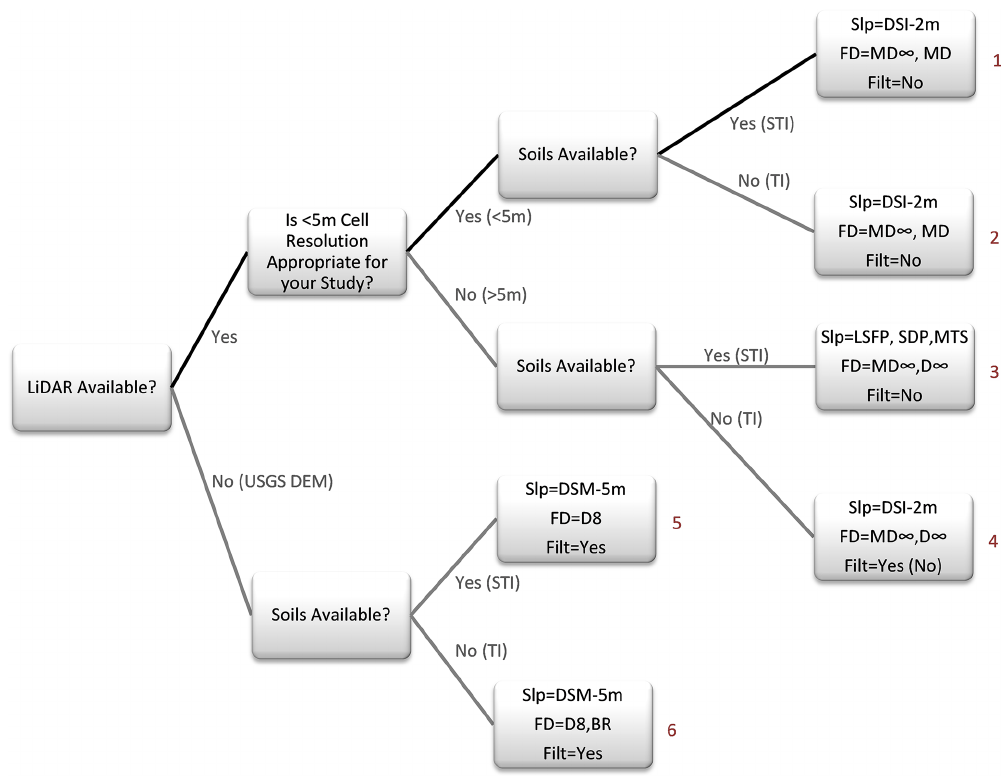
Figure A1. Decision support tree providing guidance for choosing the optimal TWI formulation in mid-slope agricultural settings. Red numbers to the right of the right-most boxes rank the various options from best to worst (one to six,